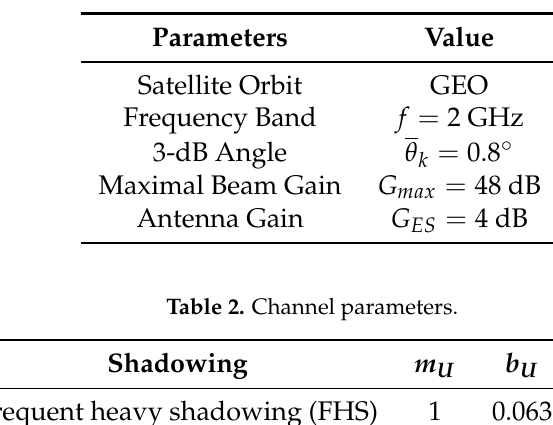
Table 1. System parameters.